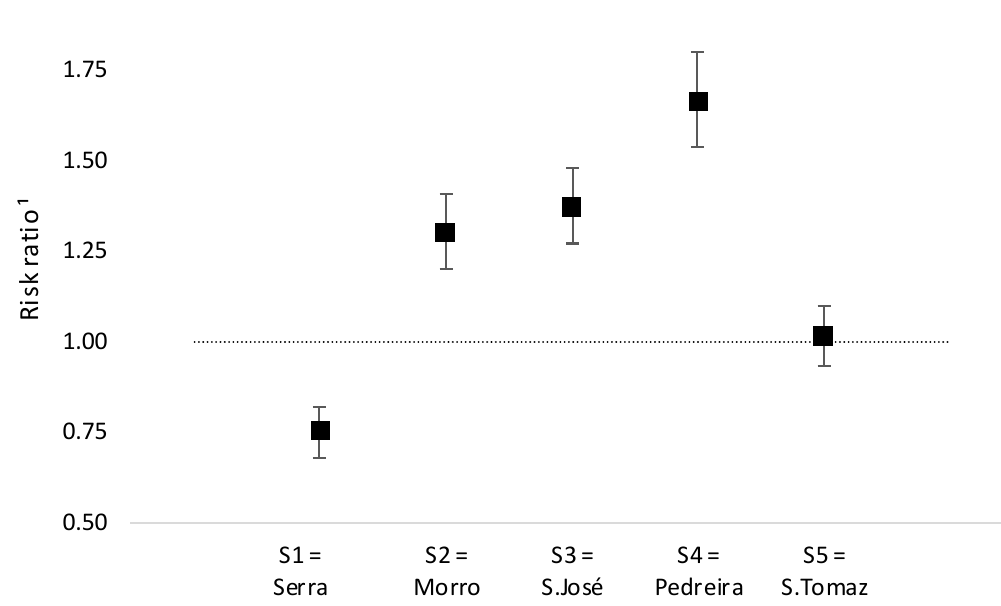
Figure 4. Risk ratio for homicides comparing intervened slums to grouped non-intervened slums. Legend: Poisson regression; reference: S0.